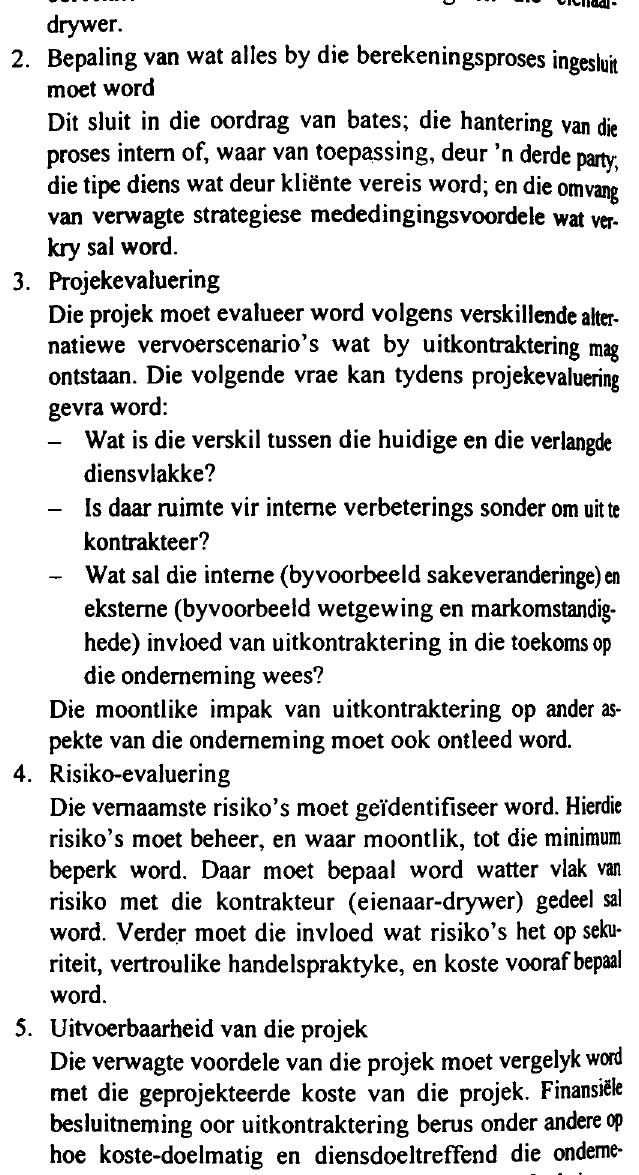
naar-drywerstelsel wil implementeer, moet aanvaar dat d~e veranderiho in distribusiemetodes kompleks en